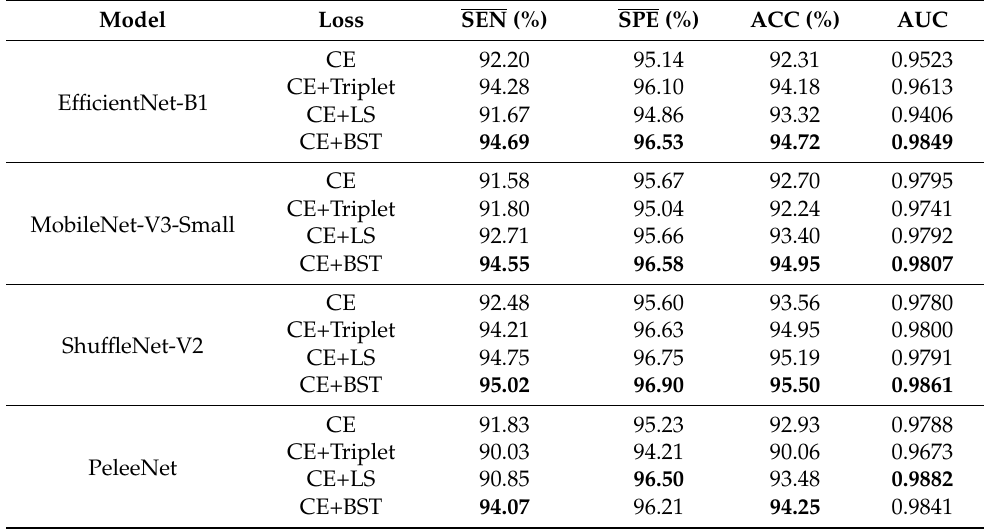
Table 4. Metrics for the compared networks on the Chest-1